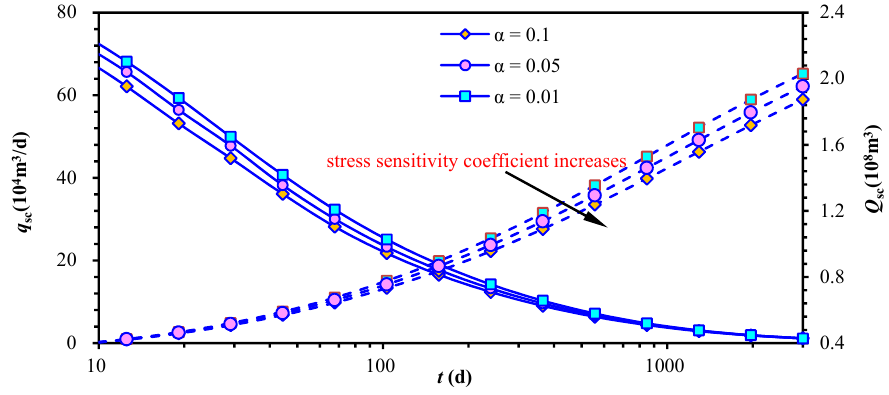
Figure 18. Effect of stress sensitivity coefficient on production performance of a MFHW in shale.